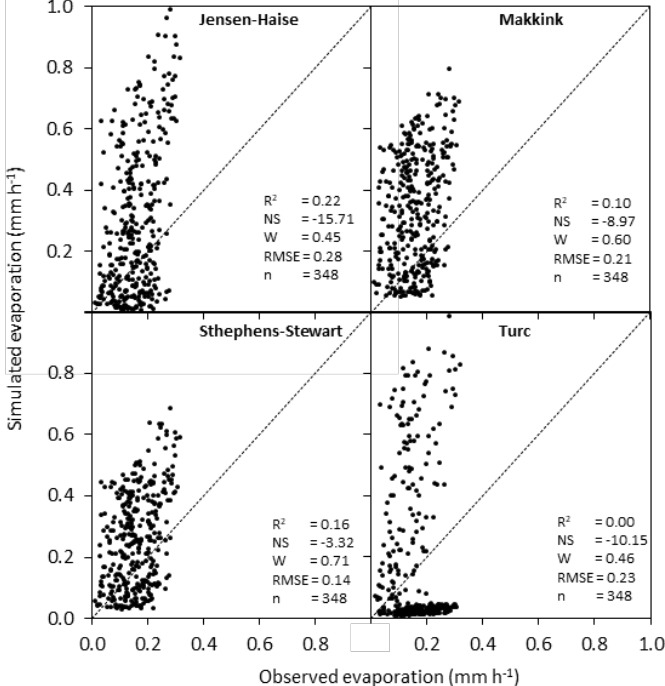
Figure 10. Relationship between measured and estimated E with the equations of the solar radiation and temperature group.